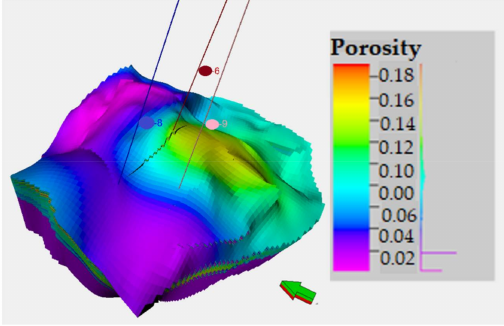
Figure 2. D porosity distribution